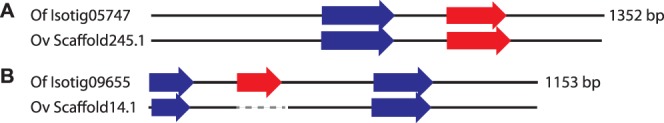
Sequence conservation between Onchocerca flexuosa and O. volvulus.
O. flexuosa transcripts containing Wolbachia-like sequences were compared with the latest version of the O. volvulus genome assembly. Eighteen O. flexuosa isogroups (24 isotigs) and eight singletons with Wolbachia-like sequences shared at least 80% sequence identity with sequences from O. volvulus over 80% of the length of the O. flexuosa transcript. For example, O. flexuosa isotig05747 shares 90% sequence identity with a 1344 bp portion of O. volvulus scaffold245.1; both of these sequences contain a similar Wolbachia-like insert (A). Another nine O. flexuosa isogroups (9 isotigs) and one singleton matched O. volvulus sequences, except the latter did not contain Wolbachia-like inserts. For example, the sequences before and after the Wolbachia-like insert in O. flexuosa isotig09655 share 84% and 89% sequence identity with corresponding regions of O. volvulus scaffold14.1, respectively; however, the Wolbachia-like sequence present in O. flexuosa is not present in O. volvulus (B). Regions sharing sequence identity with Wolbachia are indicated in red while regions similar to nematode genes are indicated in blue. Arrows indicate directionality of high-scoring segment pairs. The grey dashed line represents a gap in the sequence alignment between the two species.